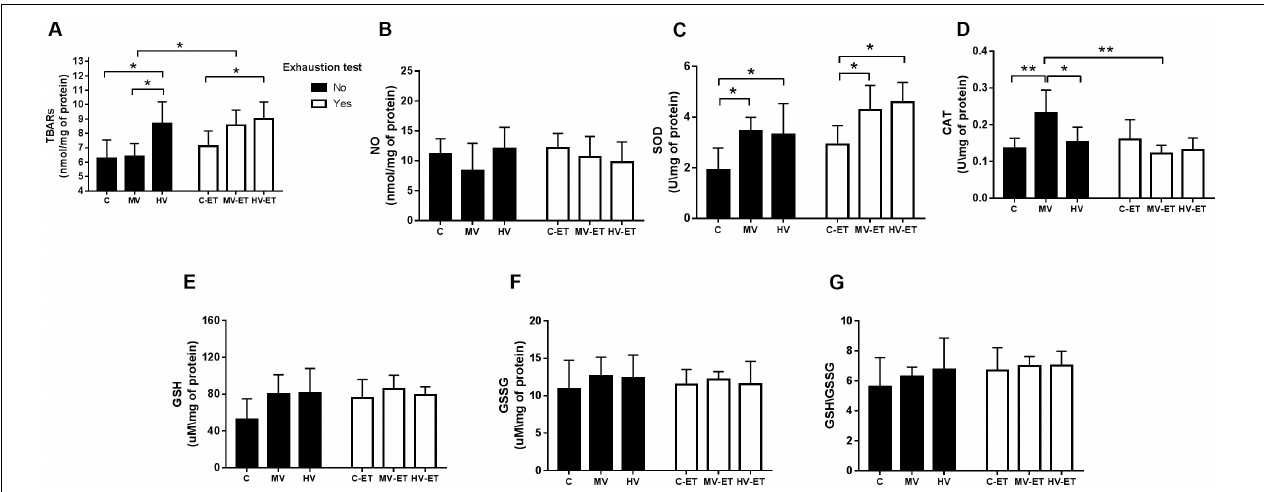
FIGURE 5 | Oxidative Markers in the cerebellum tissue. (A) TBARS: MV-ET vs. MV ( P = 0.021). HV-ET vs. C-ET ( P = 0.032). HV vs. C ( P = 0.036) and MV ( P = 0.027). (B) NO: Nitric Oxide; (C) SOD: Superoxide dismutase; MV vs. C ( P = 0.020); MV-ET and C-ET ( P = 0.034); HV vs. C (0.048); HV-ET vs. C-ET ( P = 0.011). (D) CAT: Catalase; MV vs. MV-ET ( P = 0.001), HV ( P = 0.043) and C ( P = 0.006). (E) GSH: Glutathione; (F) GSSG: Oxidized Glutathione; (G) GSH/GSSG ratio. C, control group; C-ET, control + exhaustion test group; MV, moderate-volume group; MV-ET, moderate-volume + exhaustion test group; HV, high-volume group; HV-ET, high-volume + exhaustion test group. * P ≤ 0.05; ** P < 0.01. Values represent mean ± S.D. All the experiments were carried out in triplicate.